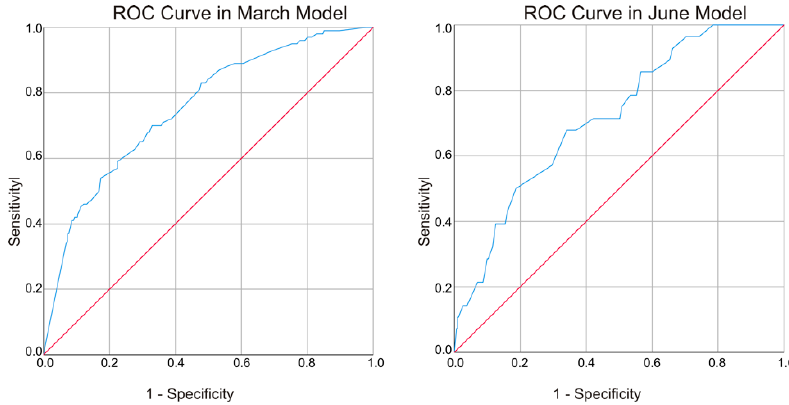
Figure 3. ROC curves in the two models. Note diagonal segments are produced by ties.